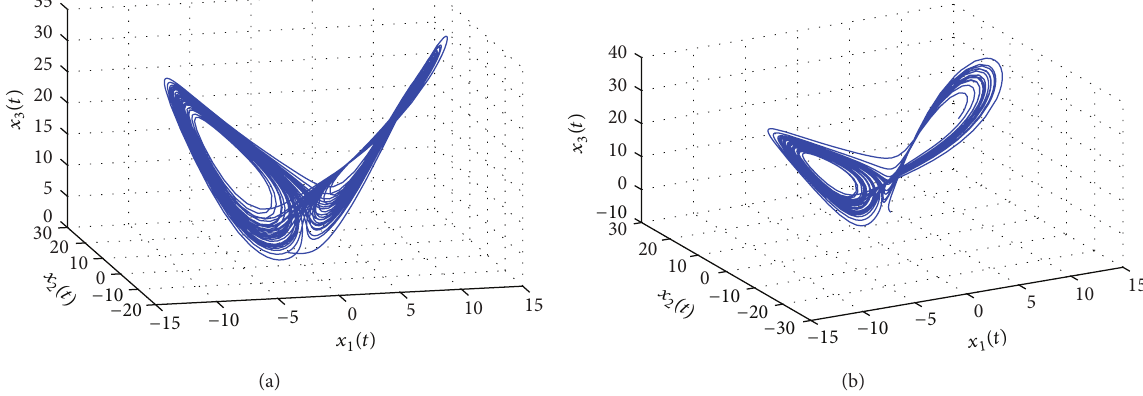
Figure 4: (a) Chaotic behavior of the master system (65). (b) Chaotic behavior of the slave system (66) without